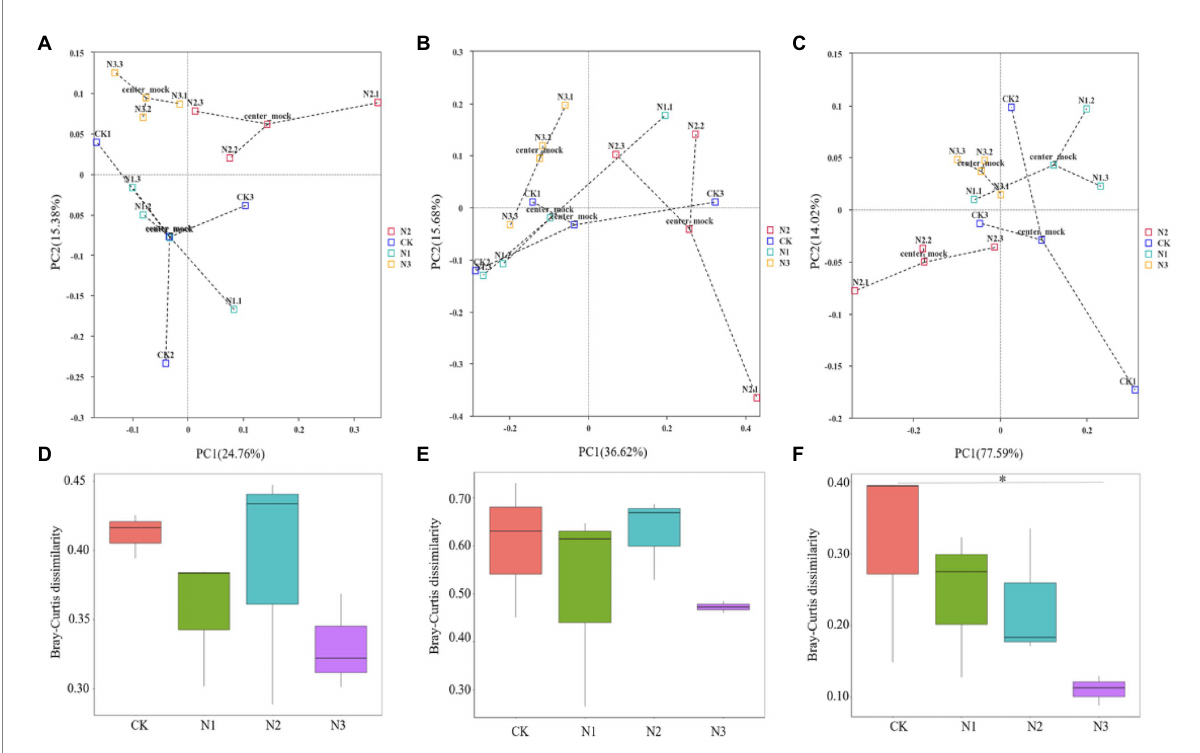
FIGURE 2 Effects of N addition on soil microbial community β -diversity revealed by PCoA analysis (A–C) and Wilcoxon rank sum test (D–F) . (A,D) Bacterial community. (B,E) Fungal community. (C,F) Archaeal community. In (A–C) , each point represents a sample, and points of the same color come from the same treatment. The closer the distance between two points is, the smaller the difference exists in community composition between them. The center mock represents the center point of the same sample confidence circle. * Indicates p <